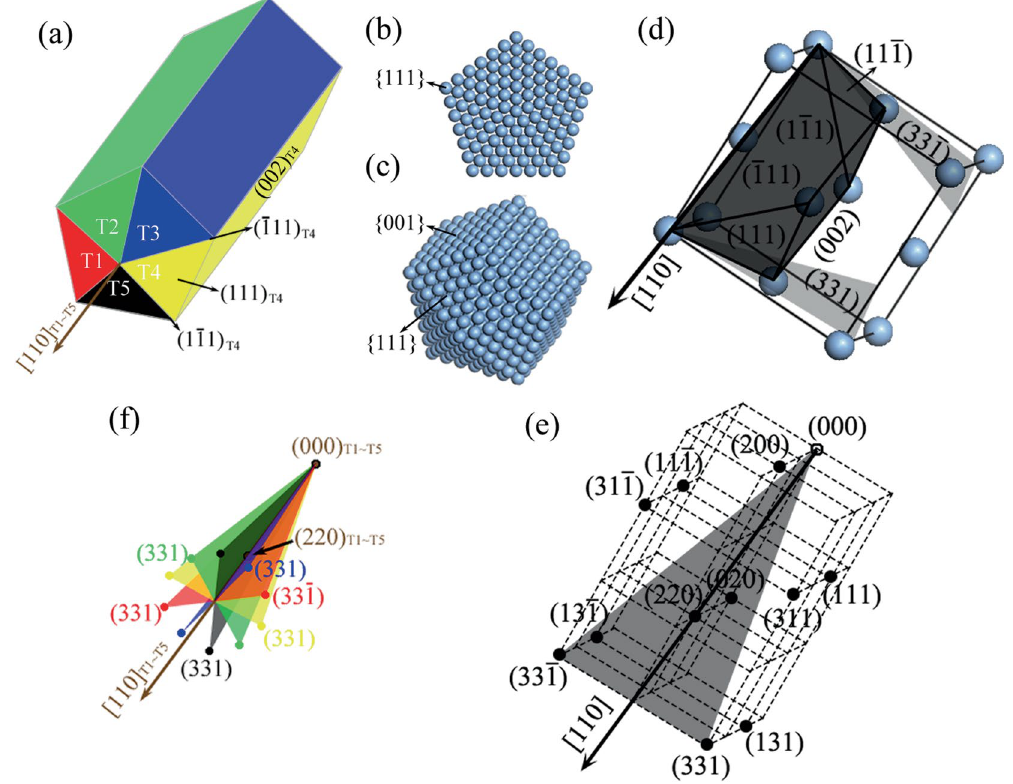
Figure 1. The ideal structural model and the reflection distribution in reciprocal space of Ag FTNWs. ( a ) The structural schematics of Ag FTNW. ( b ) Cross-sectional view and ( c ) 3D prospective view of the ideal atomic structural model of Ag five-fold twinned nanowires or nanoparticles. ( d ) The unit cell of Ag FCC lattice, in which the [110] direction is displayed and some specific crystallographic planes are shadowed and indexed. ( e ) The reflection distribution of a Ag FCC single crystal in the 3D reciprocal space. ( f ) 3D reciprocal-space distribution of (331) and (331) reflections near around the five-fold twinning axis, i.e. the [110] direction, shared by five single crystalline segments (T1~T5). The red, green, blue, yellow and black dots represent the reflections diffracted from T1, T2, T3, T4 and T5 segment,